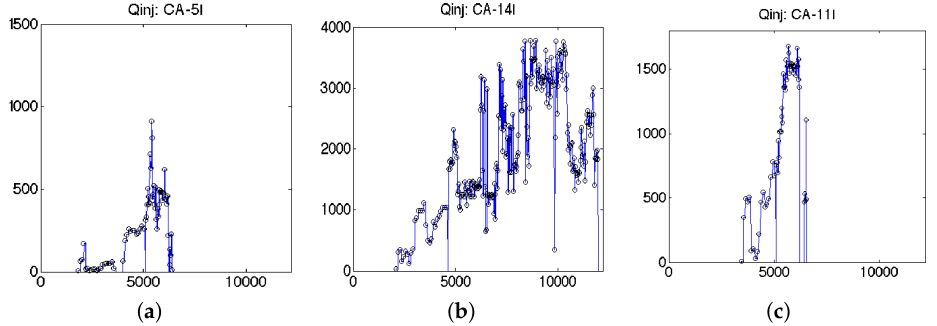
Figure 10. History of the modelled liquid flow rates for three injectors, C005 (I) ( a ), C011b (I) ( c ) and C014 (I) ( b ) out of the 19 wells.These figures have been taken from